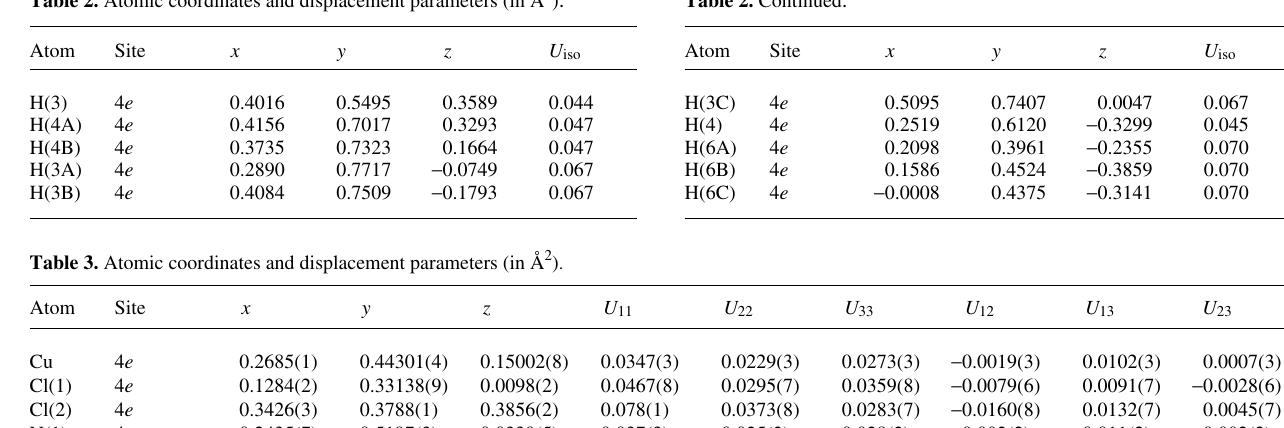
Table 2. Atomic coordinates and displacement parameters (in Å 2 )